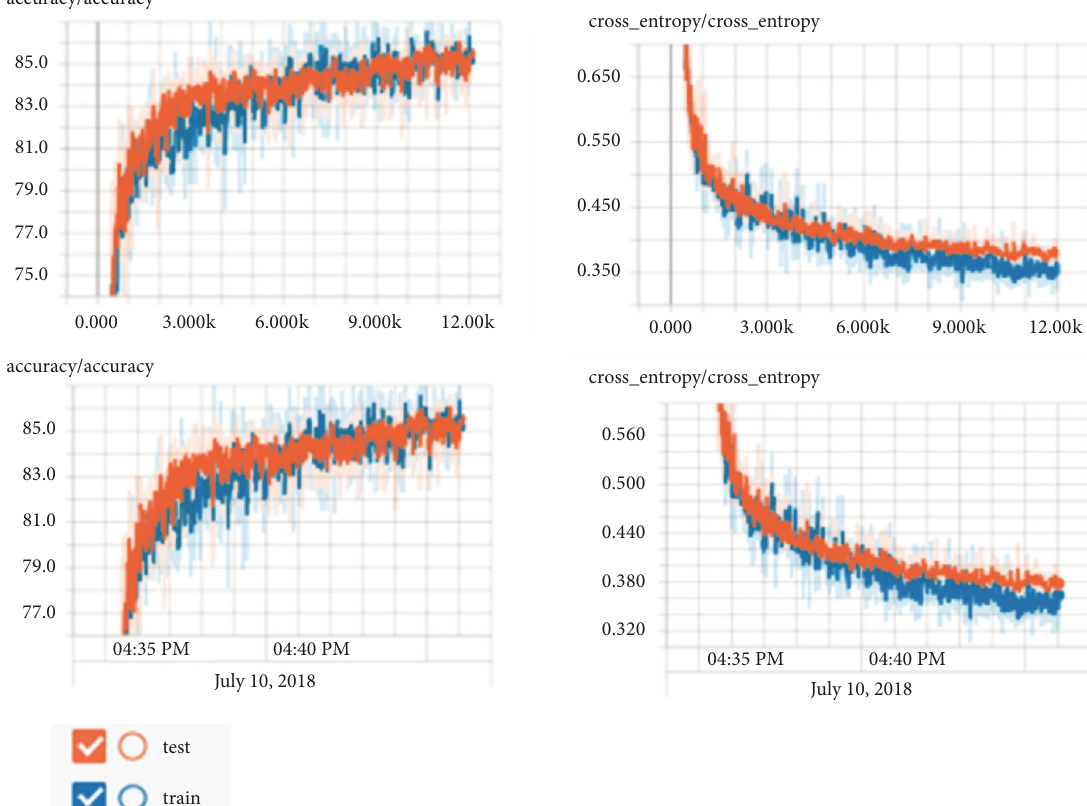
Figure 6: The cross-entropy and accuracy when re-sample weights (congestion, moderate, light, normal) are set to (0.15,0.15,0.2,0.5) and the hidden size is